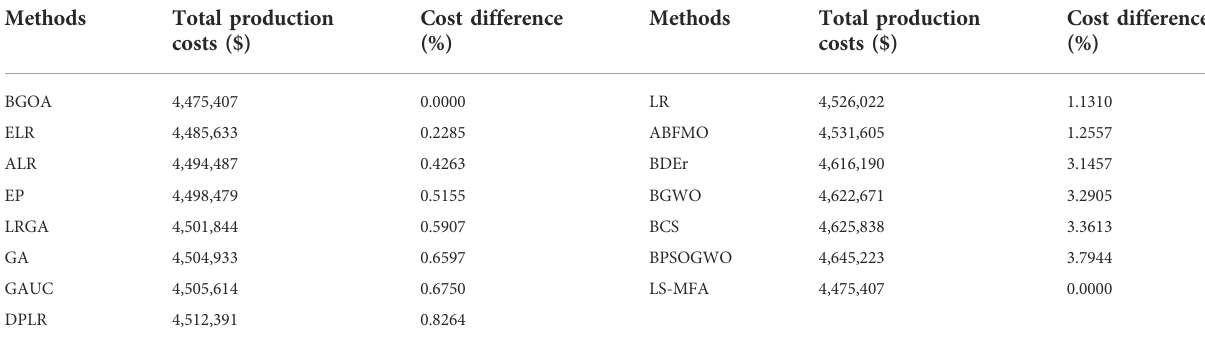
TABLE 9 Comparison of total cost with reported optimization techniques for 80-unit system.